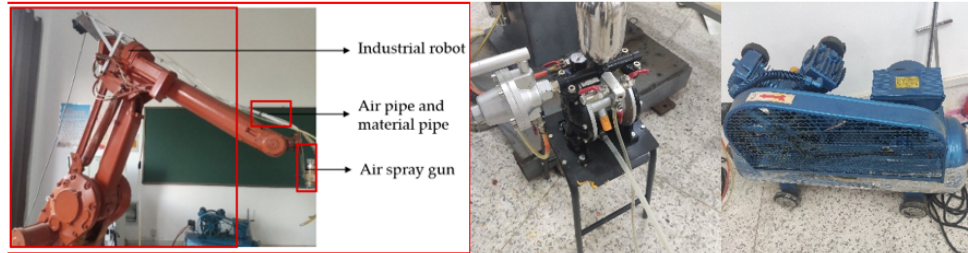
Figure 13. Spraying experiment platform, pneumatic diaphragm pump and air compressor.